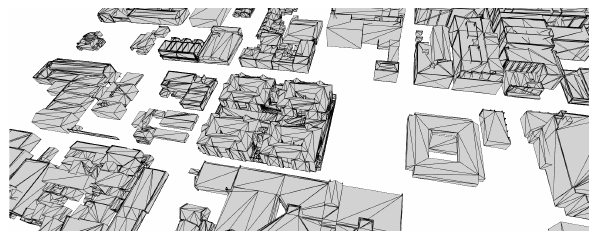
Figure 3. An example of short edges in Adelaide dataset